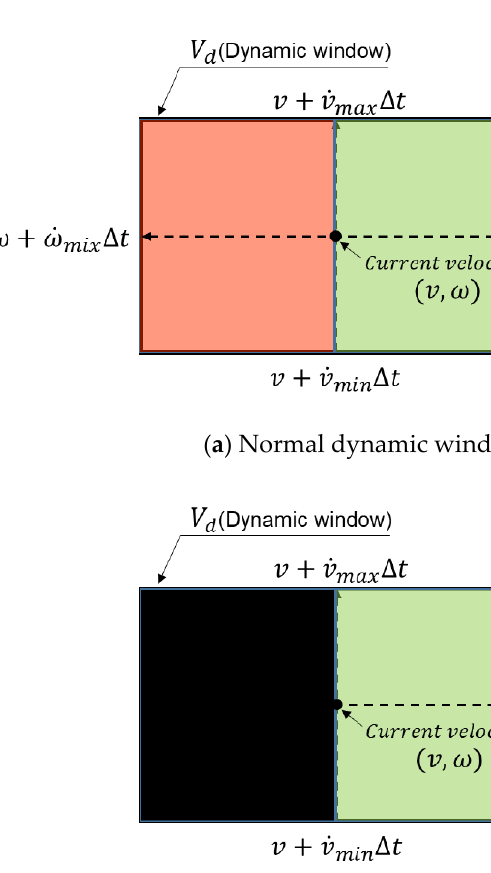
Figure 5. Flowchart of USV control.